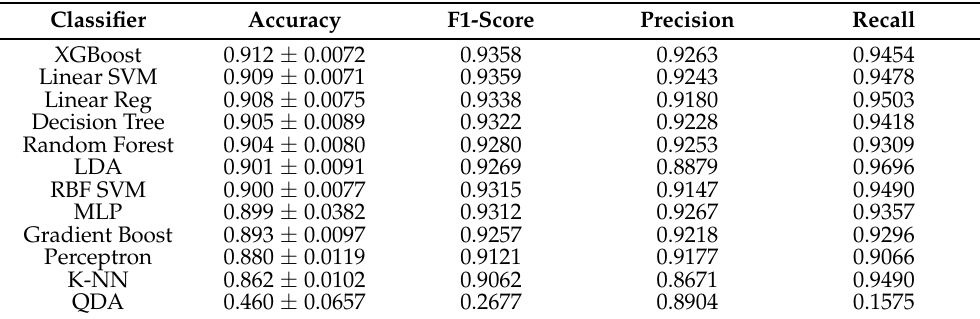
Table 2. Results of the evaluation of the machine learning models with a cross-validation approach of 30